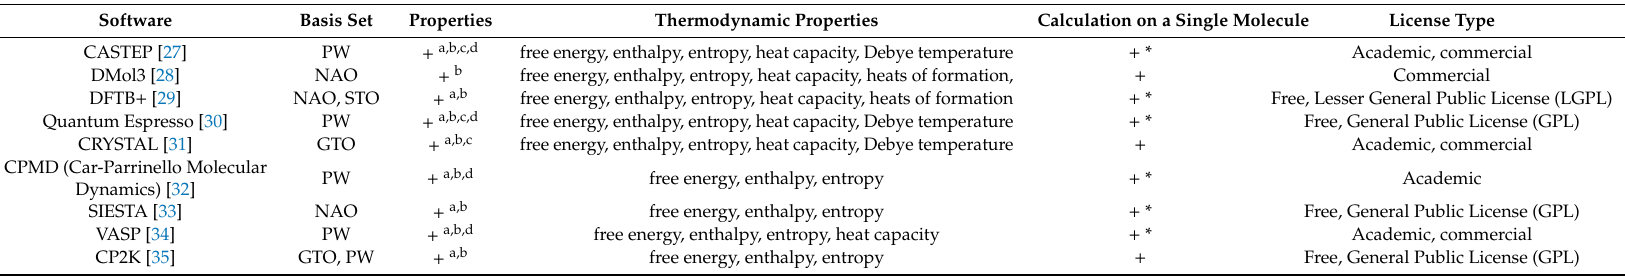
Table 1. Selected software enabling periodic Denisty Functional Theory (DFT) calculations, most commonly applied in pharmaceutical